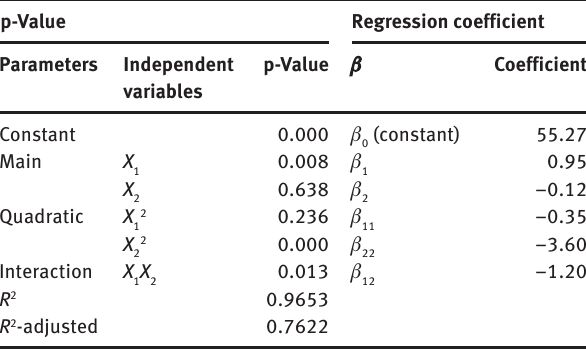
Table 4: p-Values and regression coefficients for the generated model based on the yeast strain